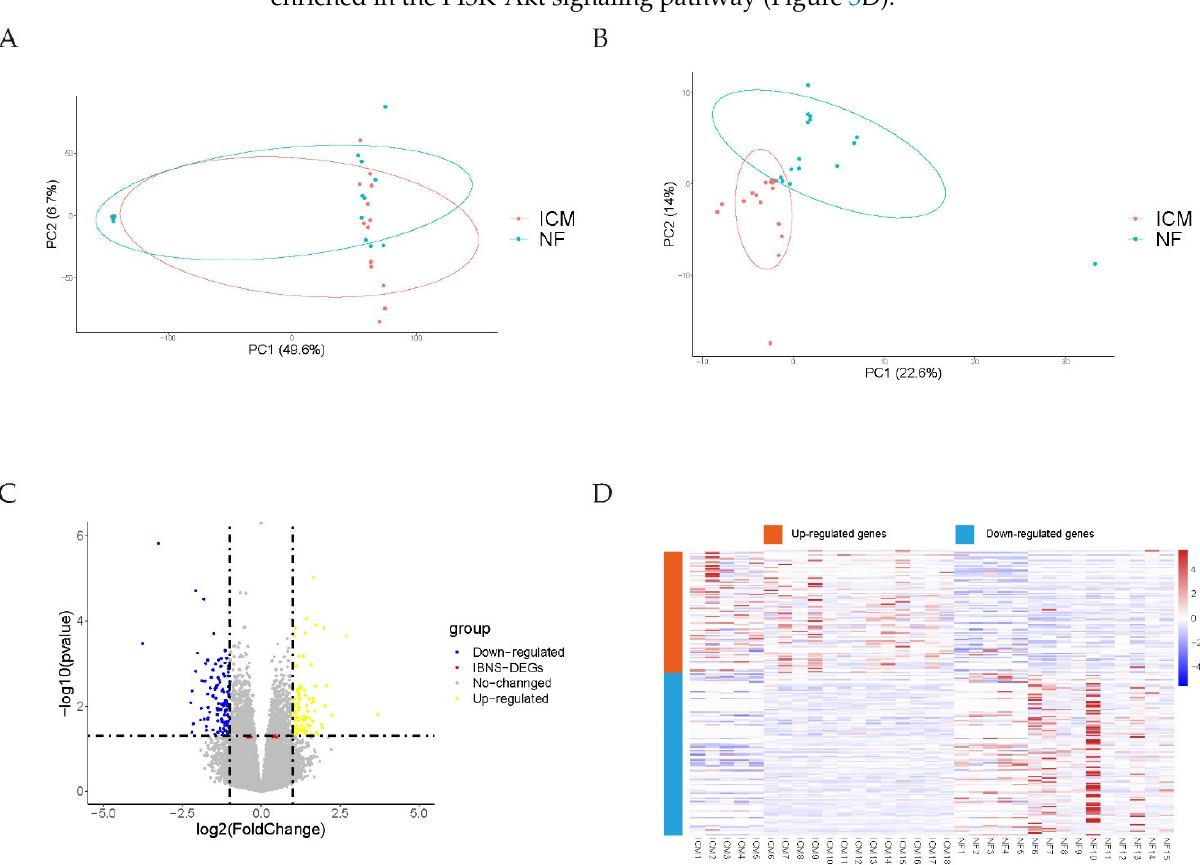
Figure 2. Merging of datasets and DEGs with the cutoff ( p value < 0.05 and |(log 2 FC)| ≥ 1). ( A , B ) PCA plots before and after removal of the inter-batch effect. ( C ) Volcano plot. ( D ) Heatmap of all DEGs. NF, non-failing heart tissue; ICM, heart tissue of ischemic cardiomyopathy patient; DEGs, differentially expressed genes; IBNS-DEGs, important-but-not-such-significantly-differentially expressed genes. Table 1. Top 50 DEGs identified in the meta ‐ analysis.